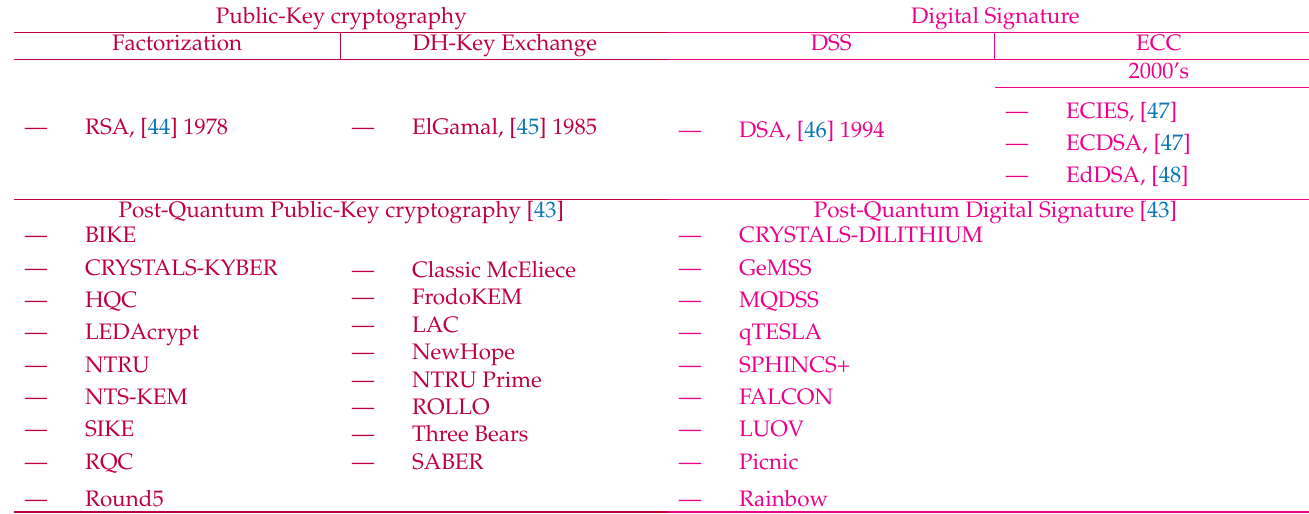
Table 2. List of asymmetric key cryptography systems. Asymmetric-Key